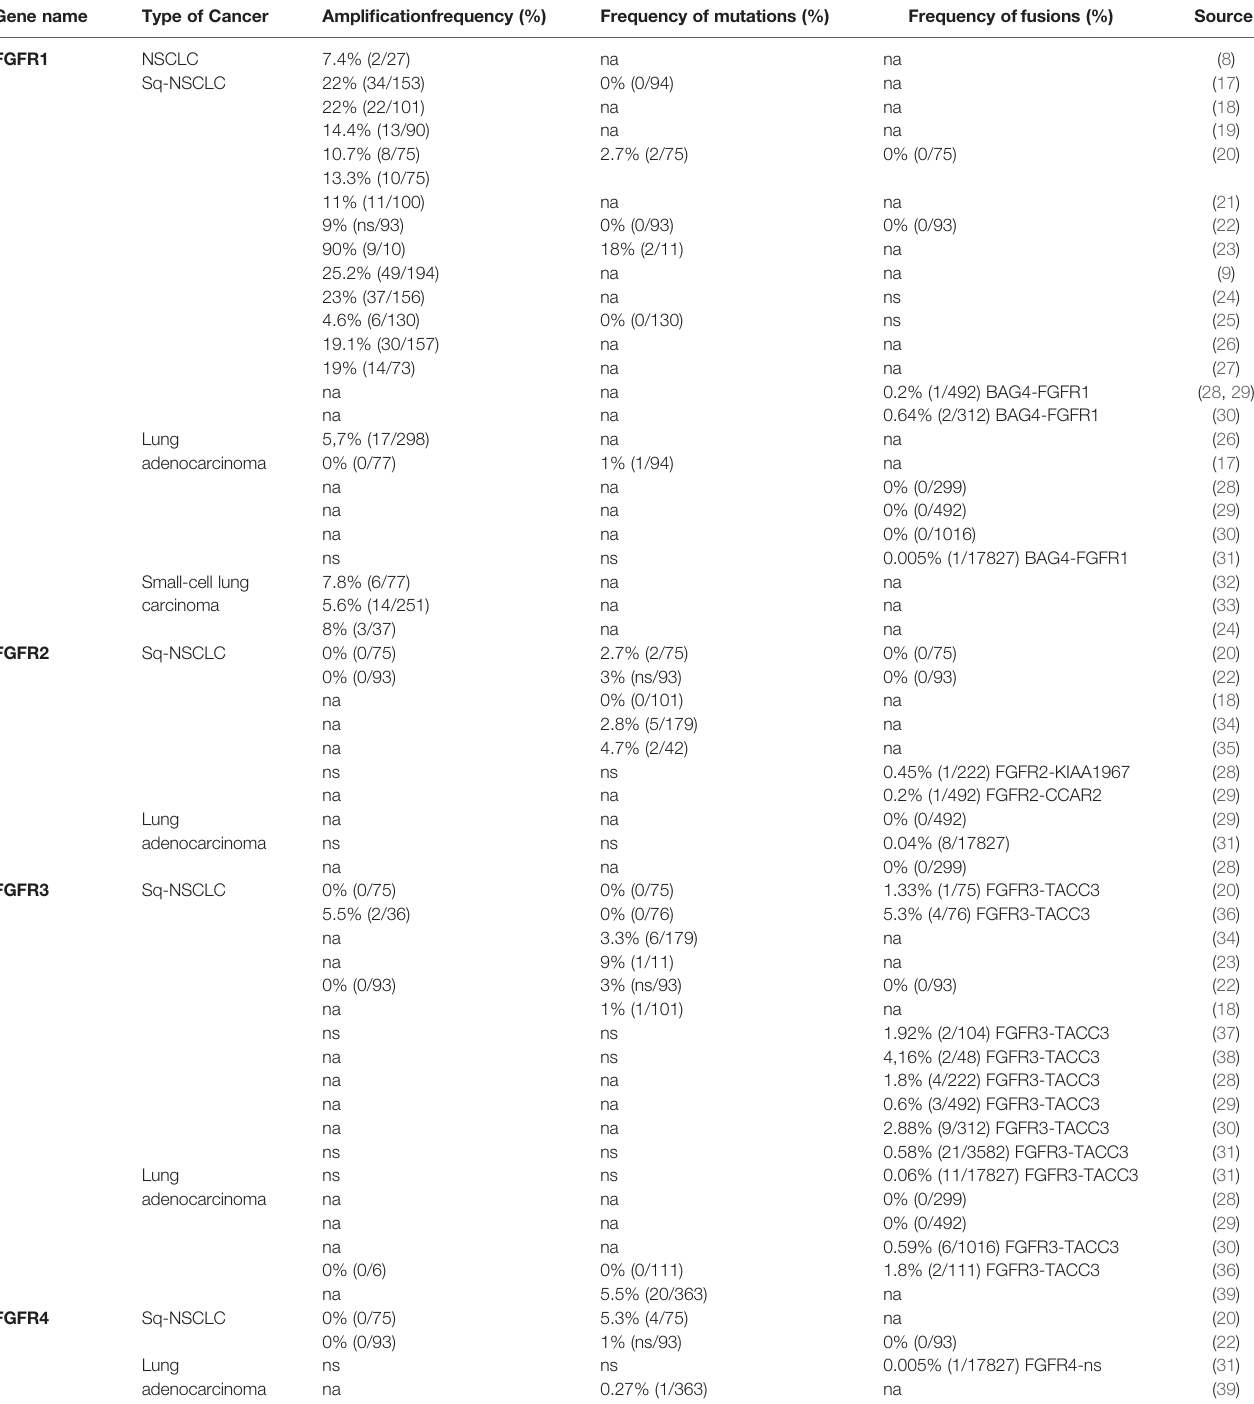
TABLE 1 | Frequencies of FGFR1 – 4 ampli fi cations, mutations, and fusions in lung